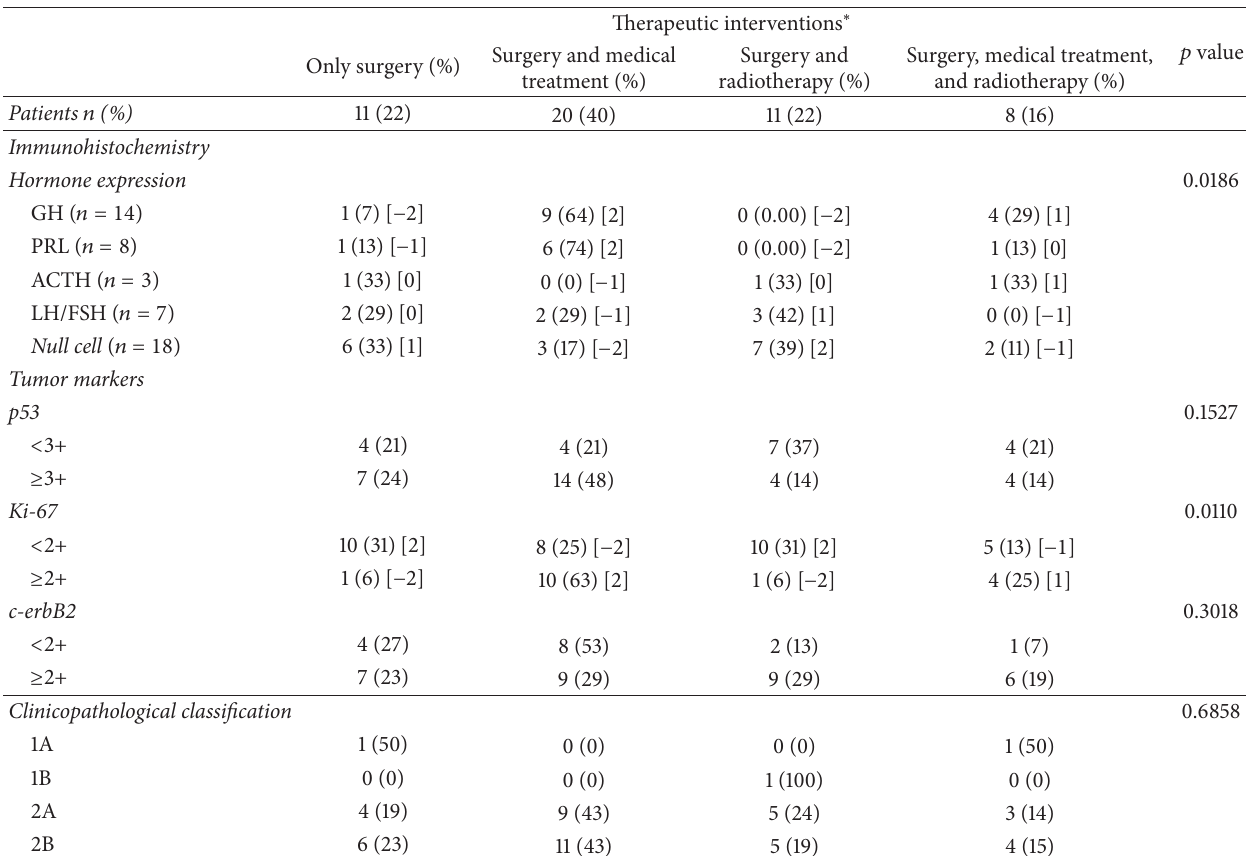
Table 5: Immunohistochemical profile, tumor classification, and therapeutic